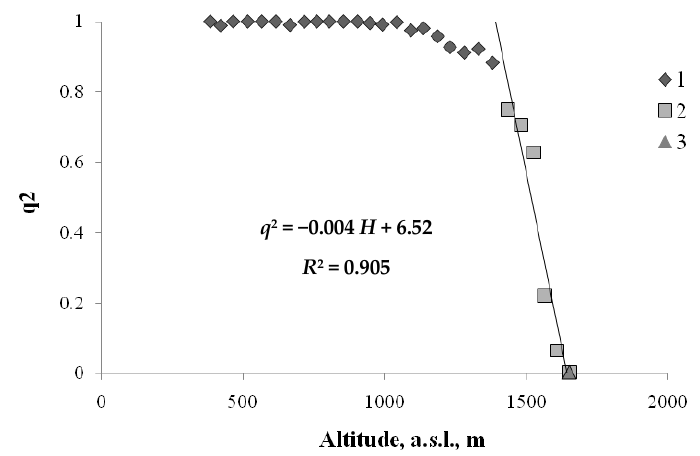
Figure 4. The frequency of occurrence of the trees versus the height of the habitats along the north-facing transect (1—forest belt (hardwood and coniferous); 2—the forest—mountain meadow ecotone; 3—the mountain meadow belt).